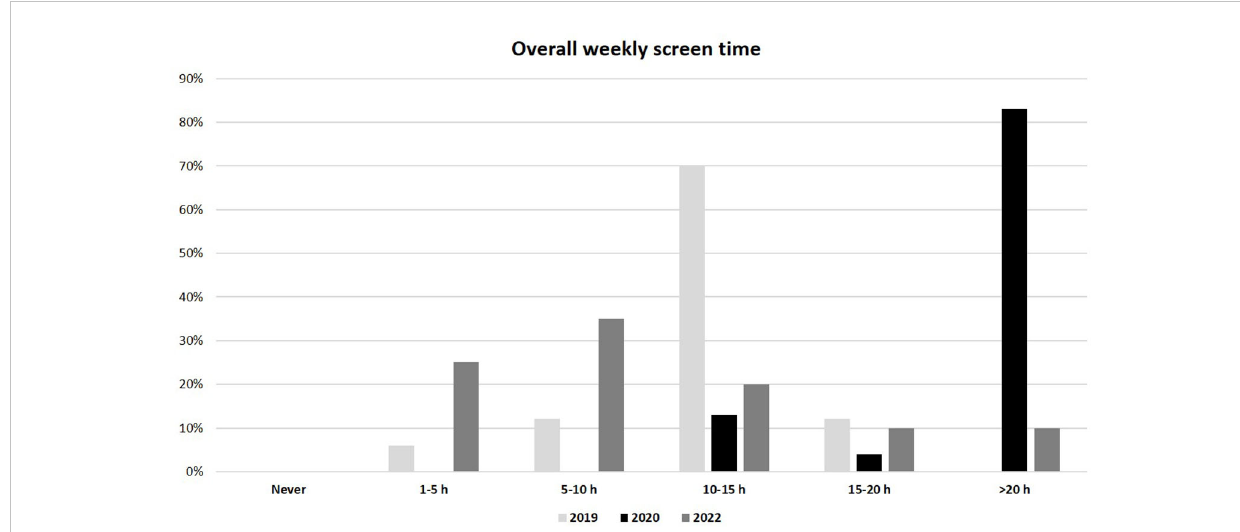
FIGURE 4 Overall weekly use of electronic devices (as tablet, PC and smartphone) in 2019, 2020 and 2022